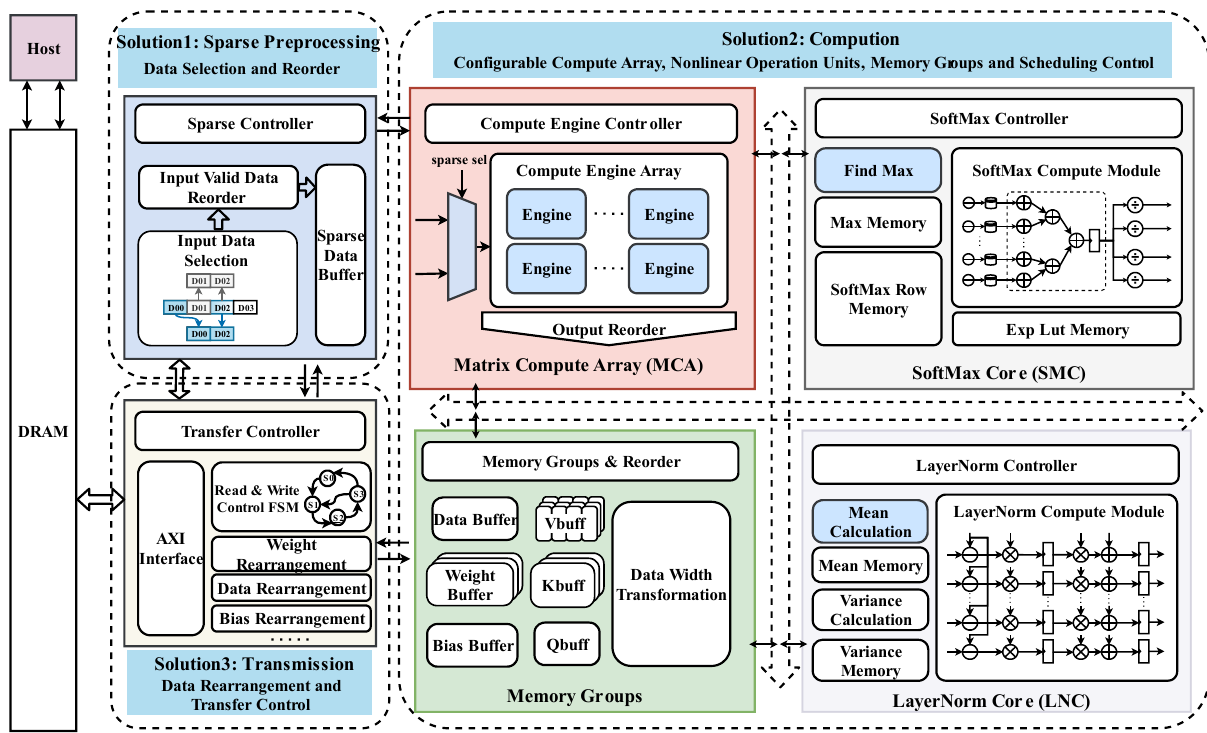
Figure 2. Top-level architecture diagram of the proposed hardware accelerator EFA-Trans.